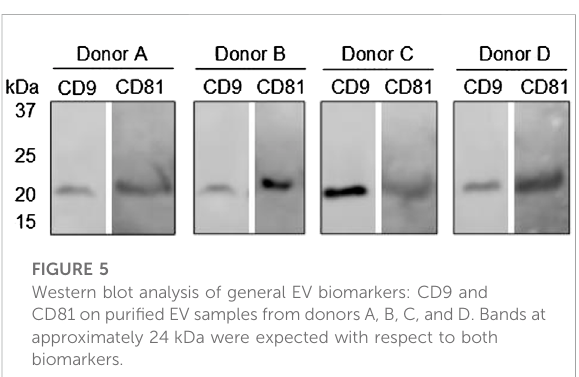
FIGURE 5 Western blot analysis of general EV biomarkers: CD9 and CD81 on puri fi ed EV samples from donors A, B, C, and D. Bands at approximately 24 kDa were expected with respect to both